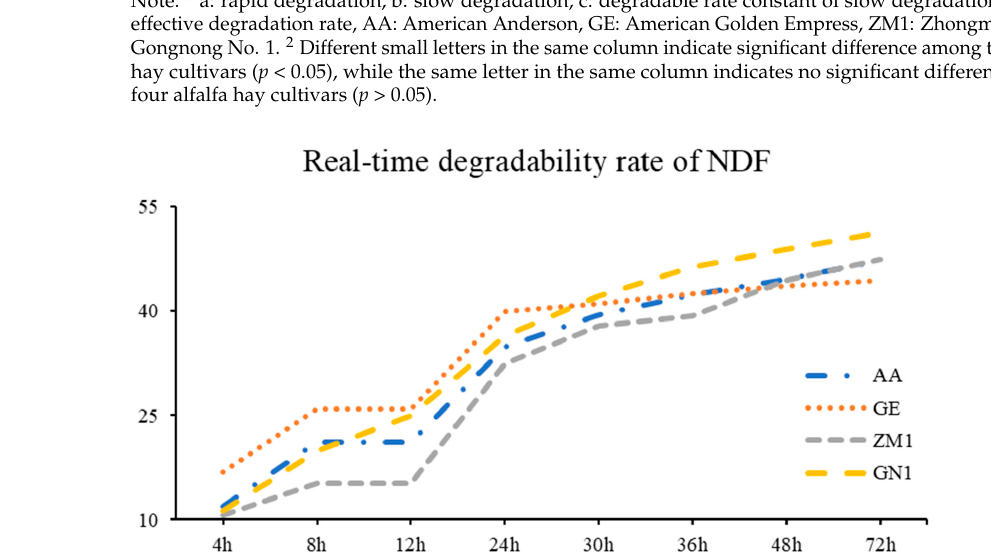
Anderson, GE: American Golden Empress, ZM1: Zhongmu No. 1, GN1: Gongnong No. 1.